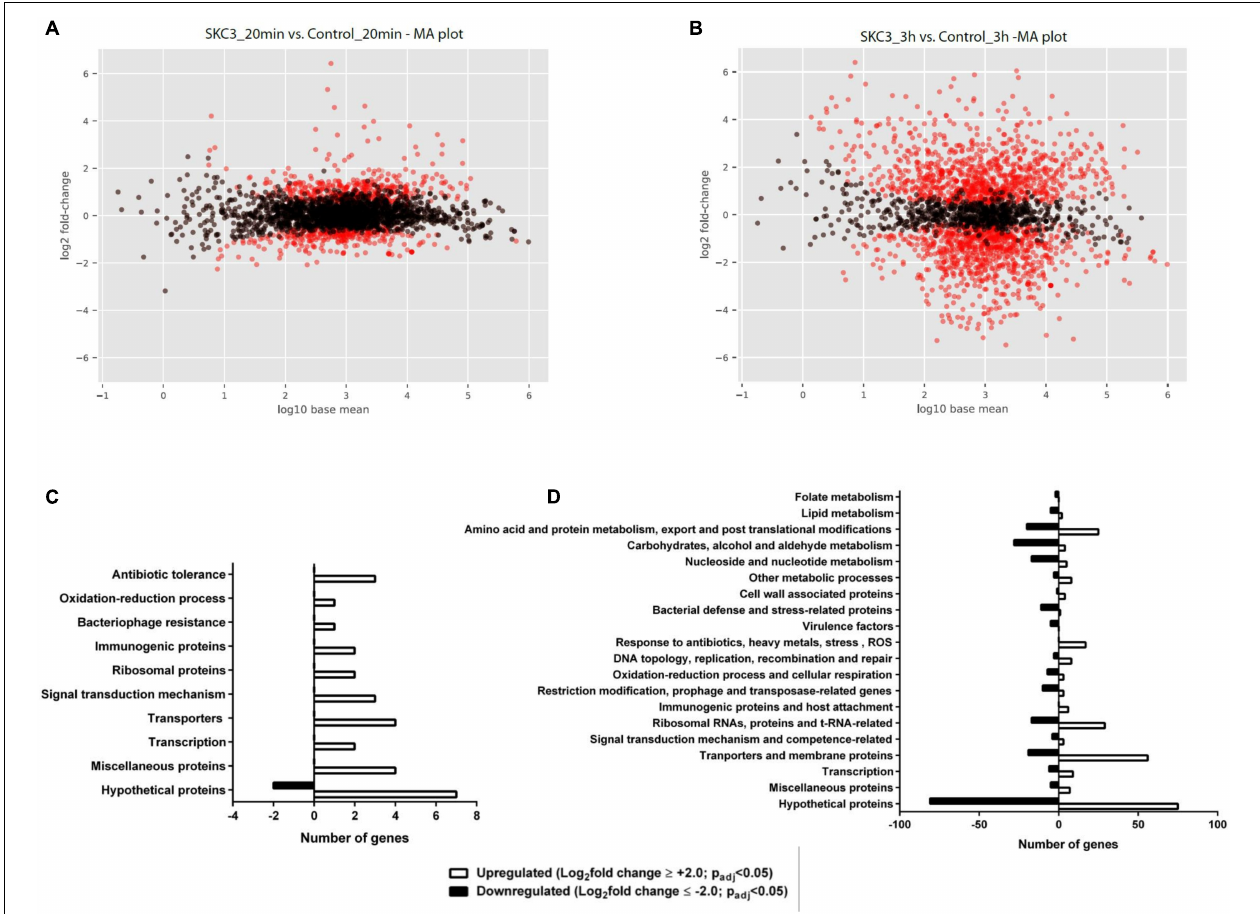
FIGURE 6 | MA plots representing the significant gene expression changes ( red dots ; p adj value < 0.05) in SKC3 (62.5 µ g/ml) treated- S. epidermidis RP62A after (A) 20 min and (B) 3 h time points in comparison with control (DMSO treated- S. epidermidis RP62A). Black dots represent the insignificant gene expression changes ( p adj value > 0.05). Histogram of differentially expressed genes in the presence of SKC3 (62.5 µ g/ml) after 20 min (C) and 3 h (D) . Results are summarized based on biological process. X-axis indicates the number of differentially expressed genes in a category. Positive and negative axes represent the numbers of up- and down-regulated genes, respectively. Absolute value of log 2 foldchange ≥ 2 or ≤ − 2 and p adj value < 0.05 was used as the threshold to screen the differentially expressed genes. UniProtKB was used to search for the biological function of differentially expressed